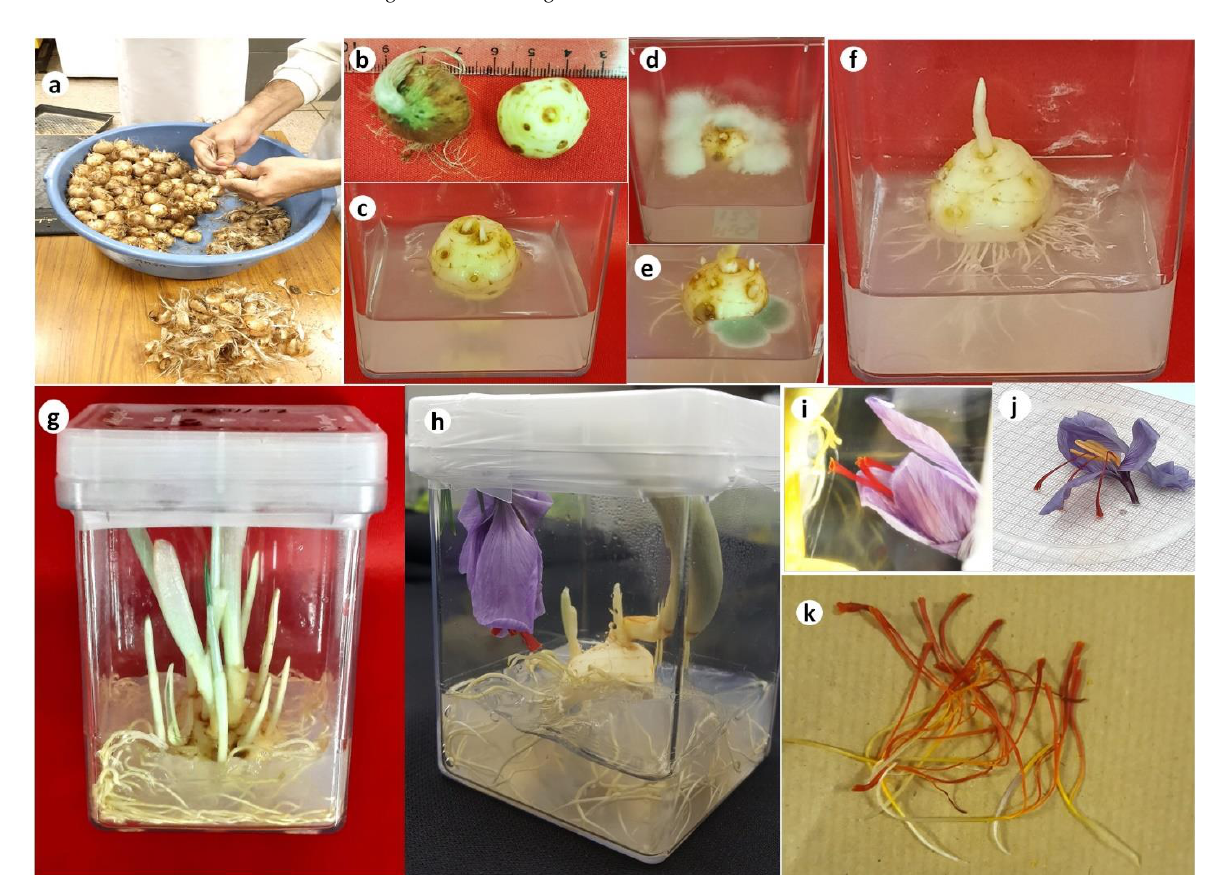
Figure 1. Surface disinfection and the establishment of in vitro saffron aseptic culture: ( a – c ) Cleaning, surface disinfection, and culture of corms on half-strength MS medium (Murashige and Skoog, 1962) supplemented with 3% sucrose; ( d , e ) Fungal contamination of in-vitro-cultured corms 1 week after incubation; ( f ) Bud break and rooting of saffron corms 7 days after incubation at 16 °C; ( g ) Shoot emergence and growth of saffron buds 3 weeks after incubation; ( h , i ) In vitro flowering of saffron corms 30 days after incubation; ( j ) Normal size and structure of in-vitro-produced saffron flowers; and ( k ) Harvested stigma of in-vitro-produced saffron . Table 1. Comparison of stigma and flower size of saffron produced under in vitro culture and via a hydroponic system (Dewir and Alsadon [16]).